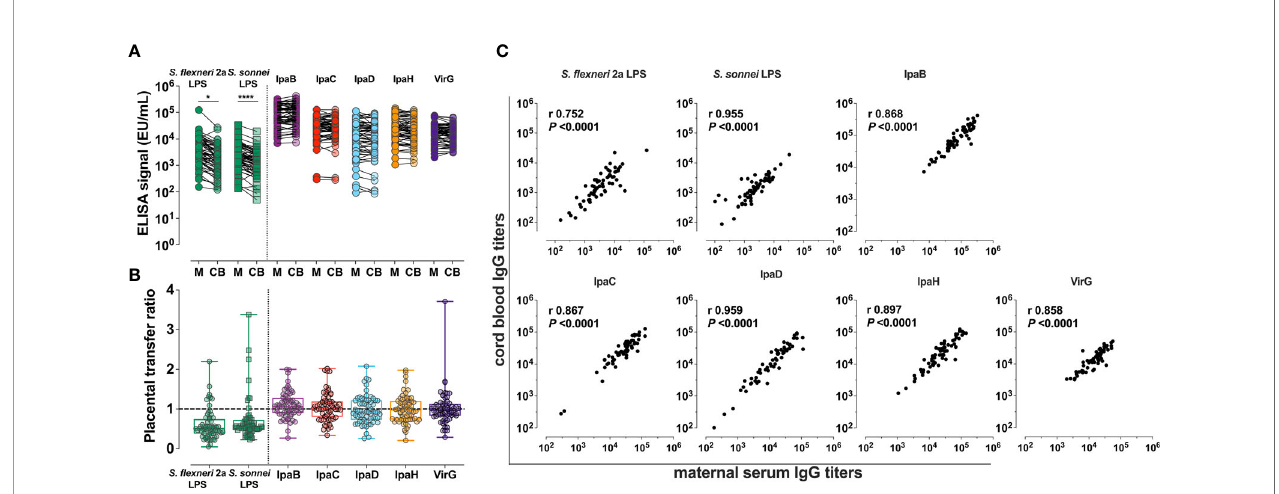
FIGURE 2 | Shigella -speci fi c maternal antibody repertoire and placental transfer ef fi ciency. (A) IgG against Shigella LPS and protein antigens in maternal (M) and cord blood (CB) sera. Symbols represent individual titers. Asterisks indicate statistically signi fi cant differences determined by paired t-test; * P < 0.05, **** P < 0.0001. (B) Placental transfer ratios (cord blood titer/maternal titer) for antibodies against each antigen. Whiskers show minimum and maximum values. Line is at ratio = 1. (C) Associations between maternal and cord blood titers for each antigen. Pearson ’ s r and P values are shown within each